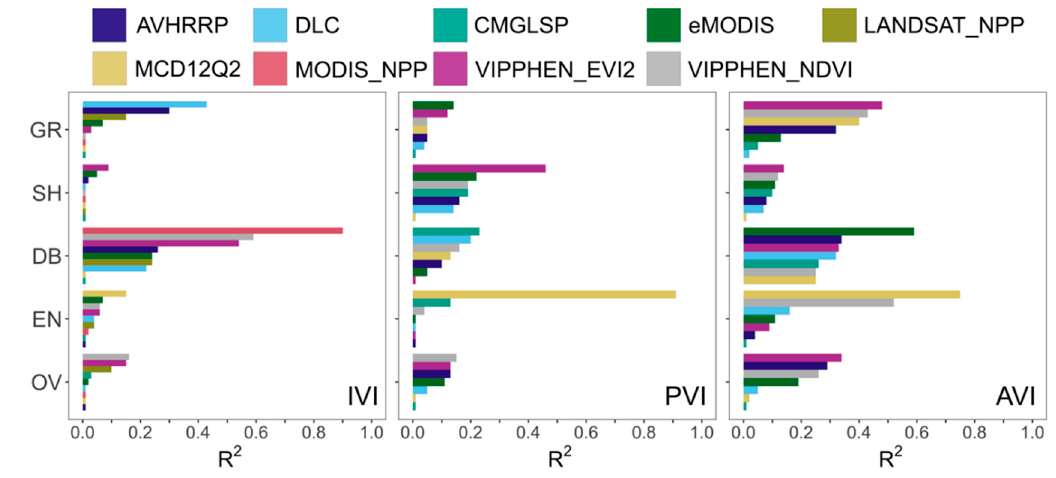
Figure 4. R 2 for three productivity metrics classified by land cover type identified in PhenoCam data and overall for all data points. The productivity metrics are integrated vegetation index (IVI), peak vegetation index (PVI) and amplitude of vegetation index (AVI). The classifications are grasslands (GR), shrublands (SH), deciduous / broadleaf (DB), evergreen (EN) and overall (OV).